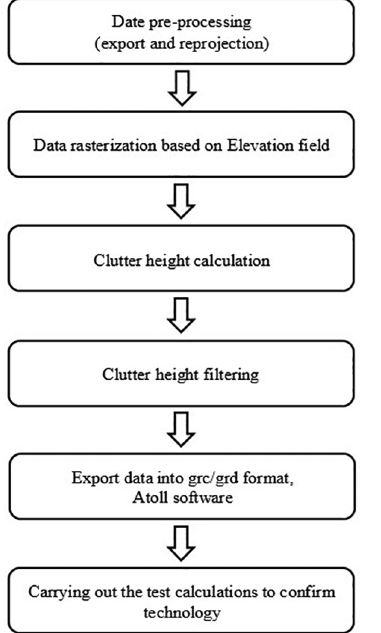
Figure 6. ArcGIS geoprocessing models for DSM